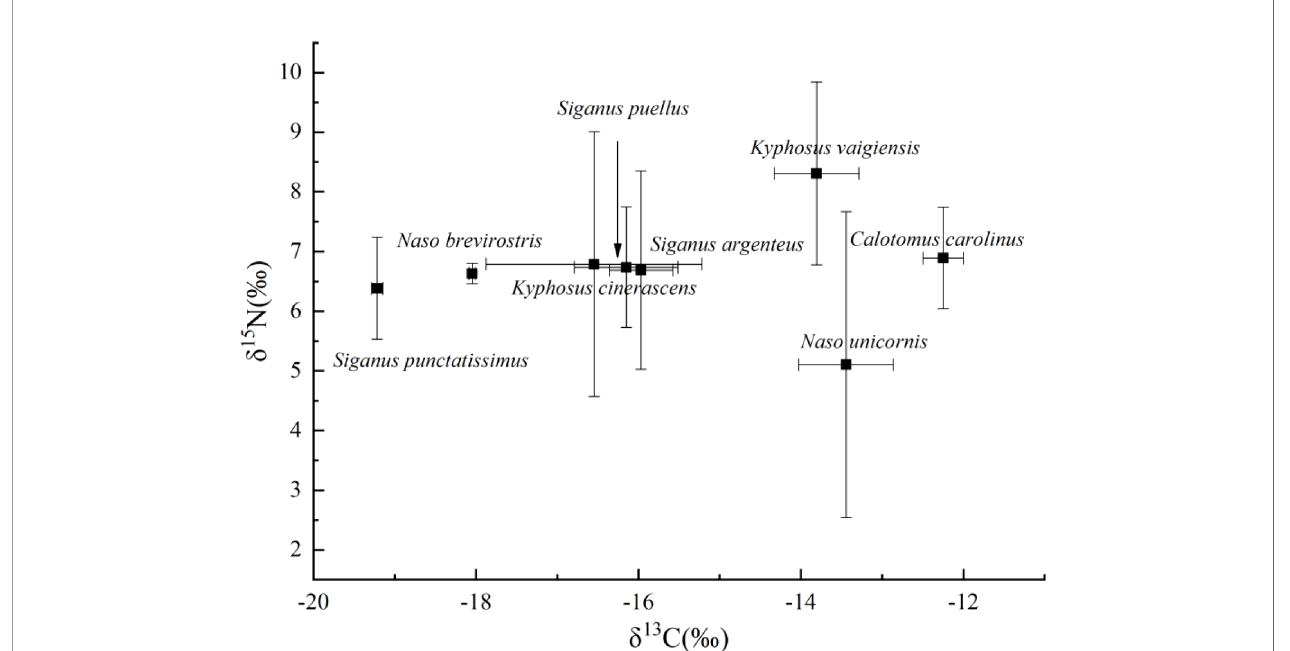
FIGURE 6 | d 13 C and d 15 N isotope values of eight coral reef fi sh species from the Xisha Islands. Data points are averages with standard error